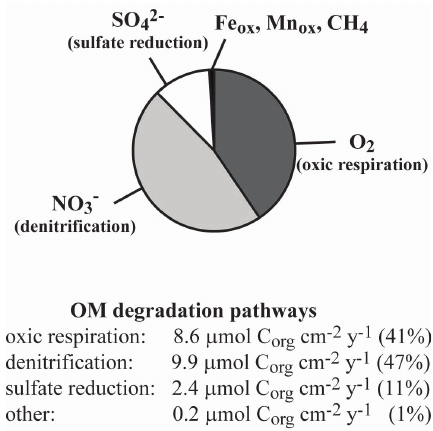
Fig. 10. The C org /P reactive ratio along the depth transect. The grey Fig. 8. Quantification of organic matter degradation pathways (as line shows the ratio as calculated from total C org and total reactive P depth-integrated rates) in the sediments from station 4: oxic respira- determined by sequential extraction, where the latter likely overesti- ) and sulfate reduction (SO 2 − ) . The tion (O 2 ) , denitrification (NO − mates reactive P burial as refractory Ca-P is included in the reactive 3 4 numbers represent organic C degradation rates in µmolcm − 2 yr − 1 , P budget (see text for details). The black line show the corrected with the relative contribution to total degradation between paren- C org /P reactive ratio, where background Ca-P is subtracted from the theses. Organic matter decomposition by dissimilatory reduction of authigenic Ca-P pool. The vertical dashed line indicates the Red- Fe (oxyhydr)oxides and Mn oxides and by methanogenesis are com- field C/P ratio of organic matter of 106. The dark and light grey bined and referred to as “other”. areas indicate the core and lower boundary of the OMZ as detailed in the caption to Fig.